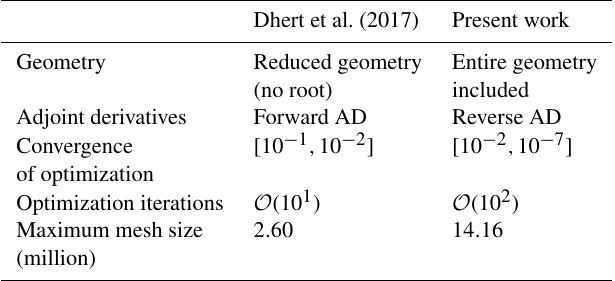
Table 2. Overview of differences between the work by Dhert et al. (2017) and the present